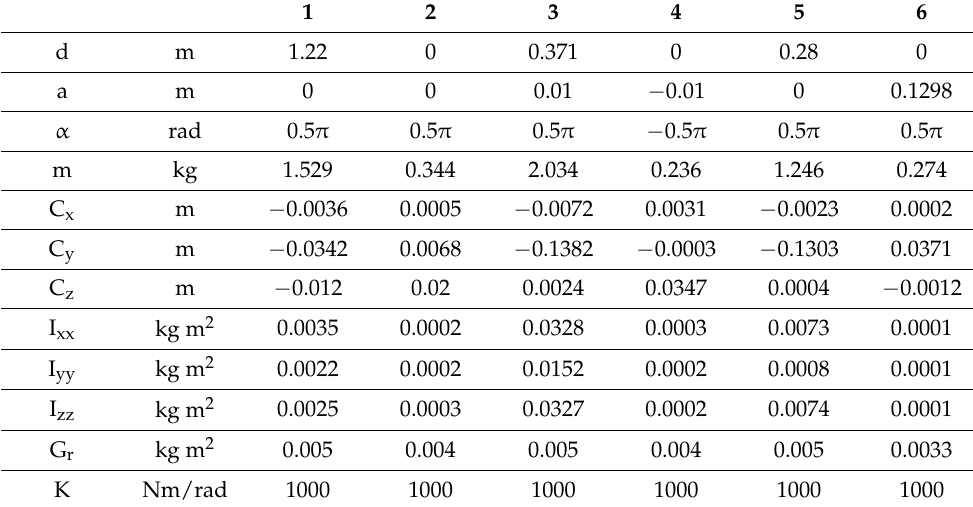
Table 1. Dynamic parameters of the 6-DOF robotic arm.